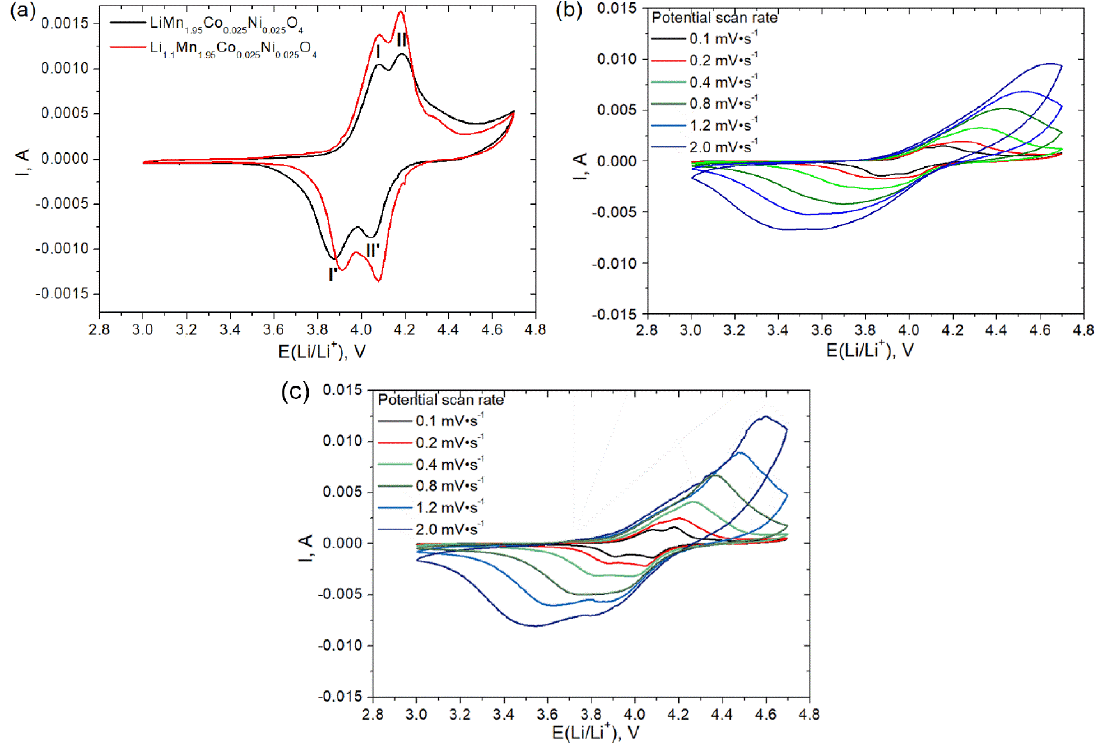
Figure 4. Cyclic voltammograms (CV) curve for LiMn 1.95 Co 0.025 Ni 0.025 O 4 and Li 1.1 Mn 1.95 Co 0.025 Ni 0.025 O 4 at the first cycle potential scan rate 0.1 mV s − 1 (mass load was 10 mg cm − 2 for both samples) ( a ) and CV curves for LiMn 1.95 Co 0.025 Ni 0.025 O 4 ( b ) and Li 1.1 Mn 1.95 Co 0.025 Ni 0.025 O 4 ( c ) obtained at different potential scan rates from 0.1 to 2.0 mV s − 1 . Cyclic voltammograms for LiMn 1.95 Co 0.025 Ni 0.025 O 4 and Li 1.1 Mn 1.95 Co 0.025 Ni 0.025 O 4 obtained at different scan rates are shown in Figure 4b,c,